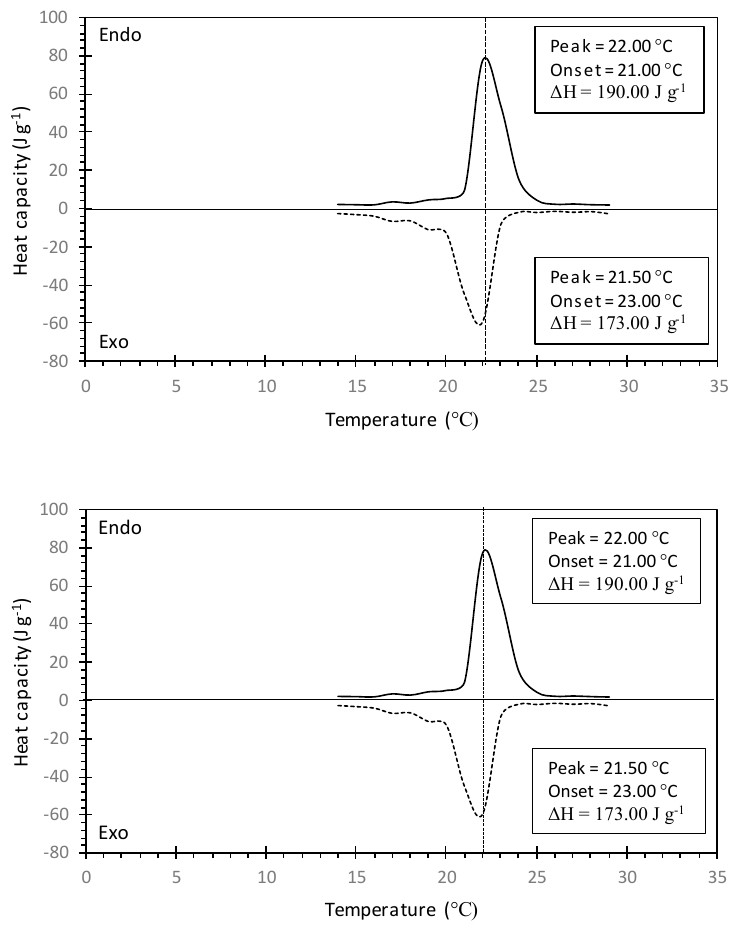
Figure 8. T-history analysis to measure enthalpy for the pure PCM SP21E.